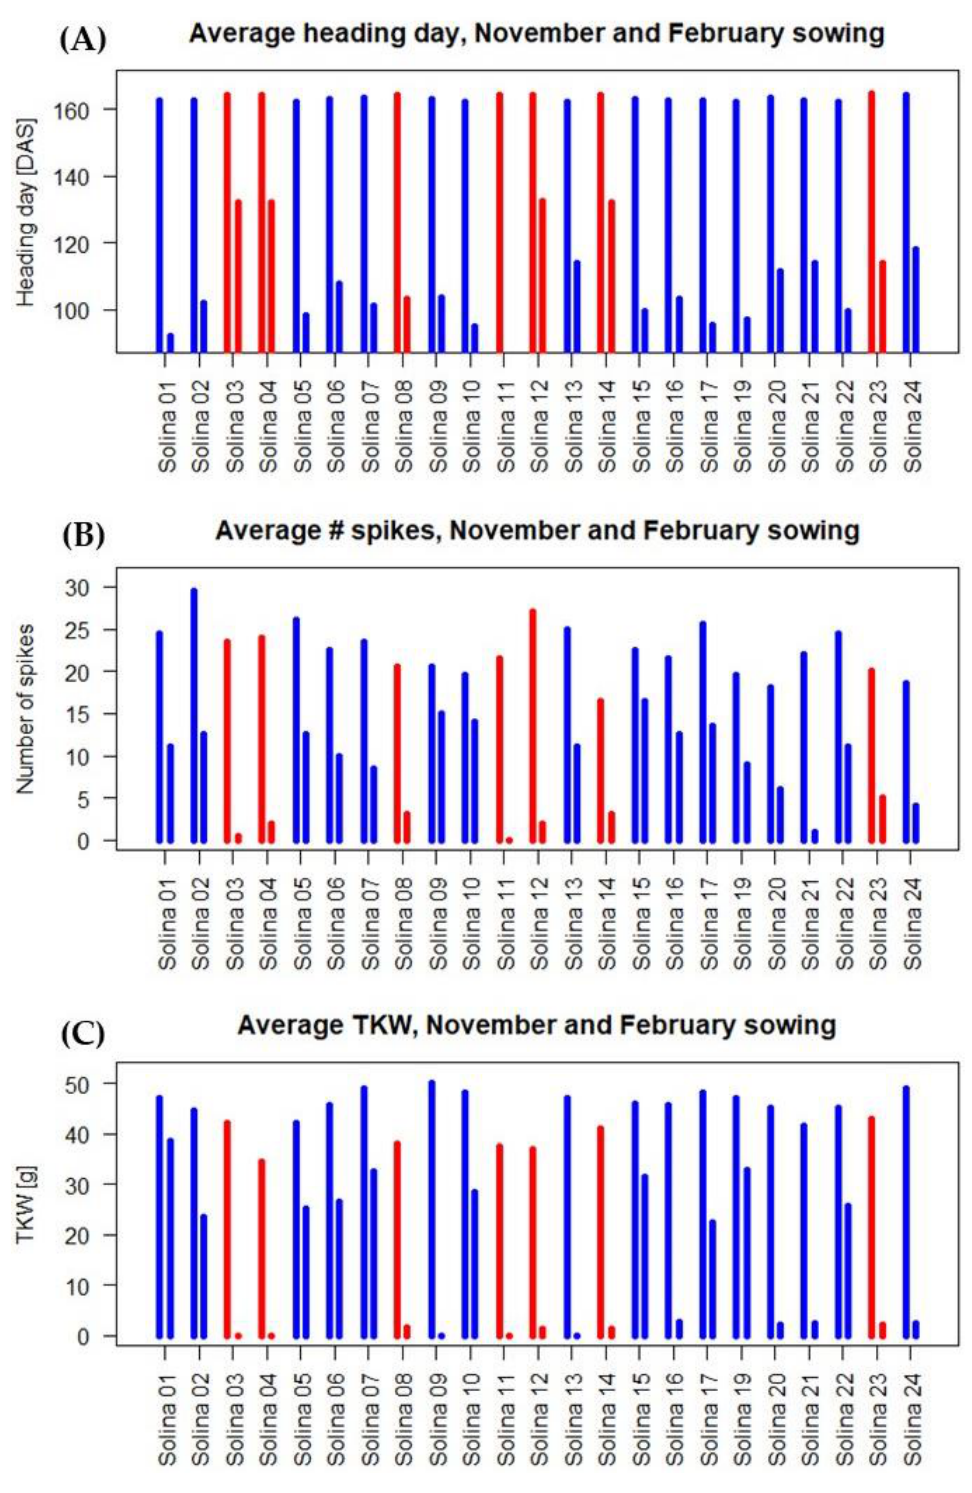
Figure 2. ( A ) Heading date (days after sowing) for November (left bars) and February (right bars) sowing, ( B ) Number of spikes, and ( C ) thousand kernel weight (g) of Solina lines are sown in November (left bars) and February (right bars). Mean values are reported. The colours of the bars indicate membership to the red and blue clusters according to De Flaviis et al. [5]. At the end of the life cycle, some agronomic characteristics were assessed, i.e., plant height, above-ground biomass, the number of spikes, and thousand kernel weight (TKW).